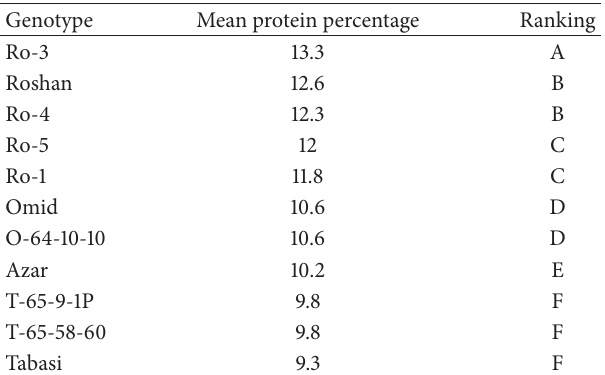
Table 3: Comparing of protein mean by Duncan’s multiple-range